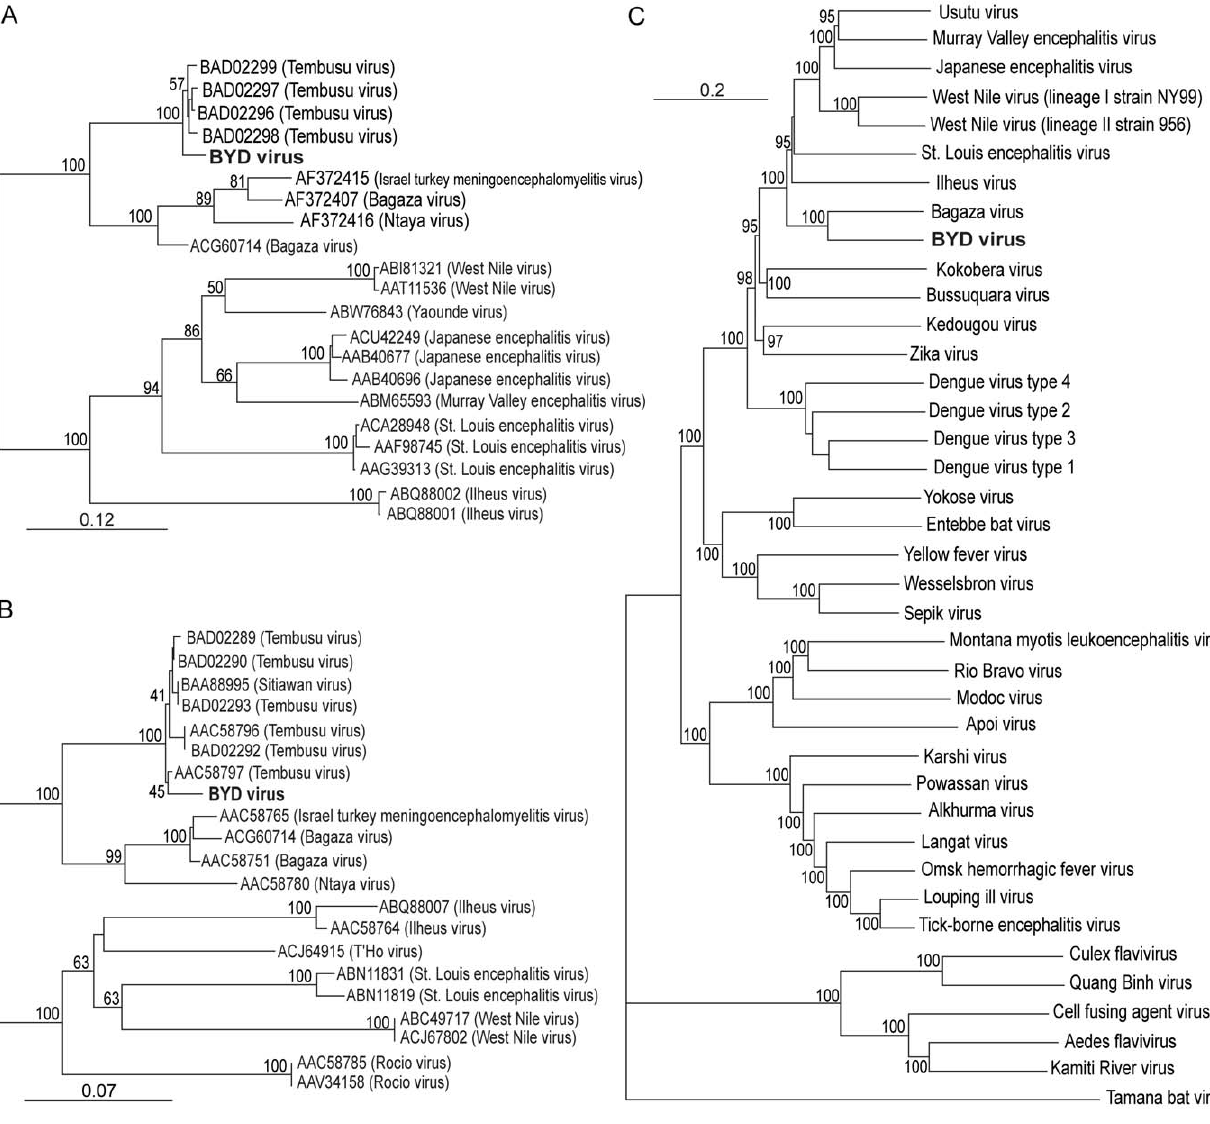
Figure 7. Phylogenetic relationships of the isolated BYDV with other flaviviruses. Nucleotide sequence comparisons of the E protein (A), NS5 protein (B) and the genome coding polyprotein (C). BYDV is labeled in bold.